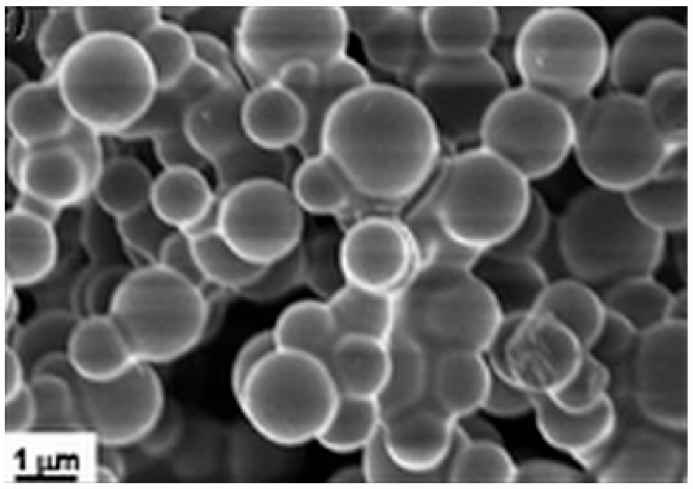
Figure 5. SEM image of biochar prepared from the hydrothermal carbonization of sucrose. Reprinted with permission from Reference [9]. Copyright (2012) Royal Society of